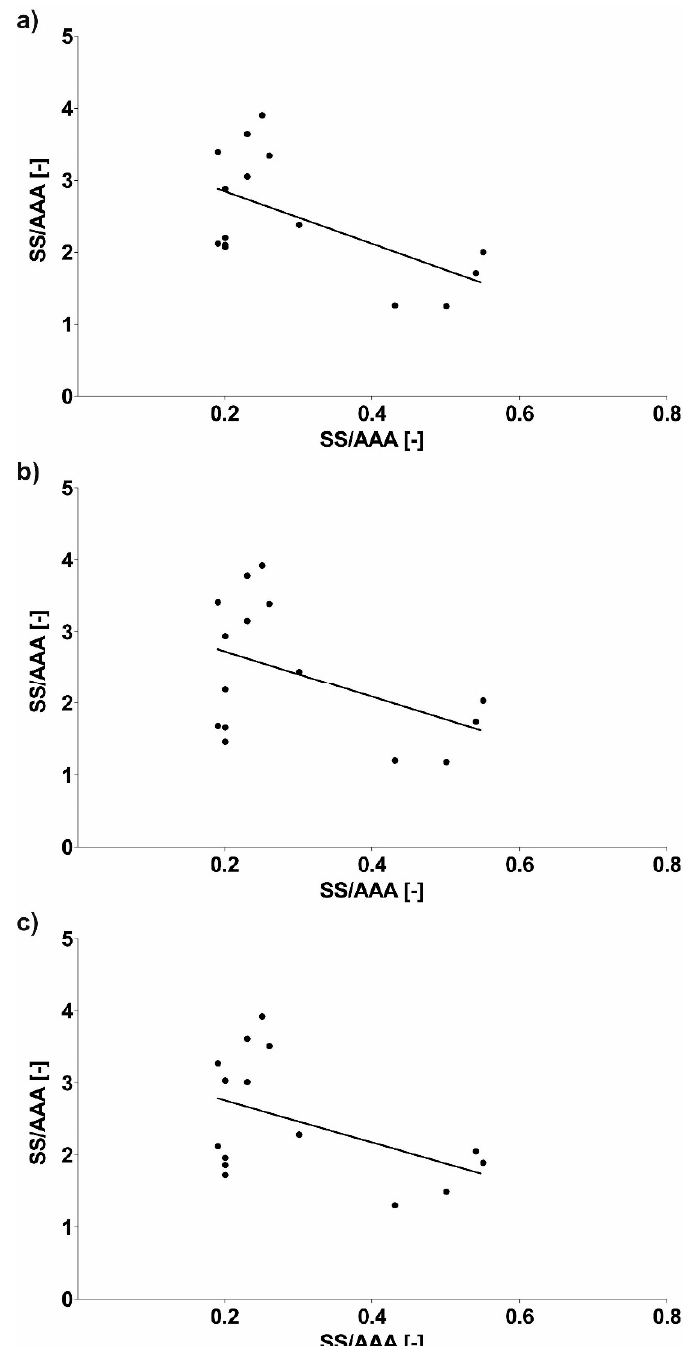
Figure 13. Scatterplot graphic representation of Pearson’s correlation factors rho [-] for the analyzed geometry of SS / AAA in function of WSS values for SS / AAA for ( a ) sharp profile (rho = − 0.5887, p = 0.021), ( b ) flat profile (rho = − 0.4537, p = 0.089), ( c ) real profile (rho = − 0.4677, p = 0.078).